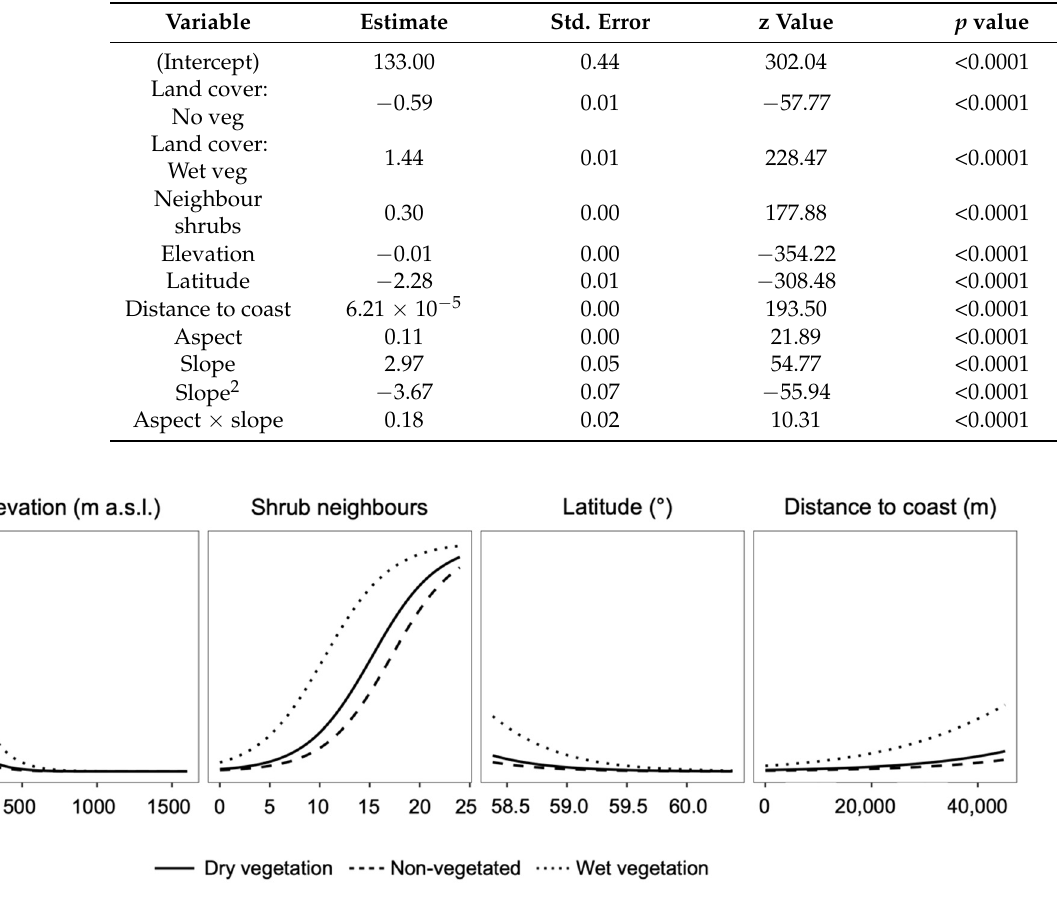
Figure 6. Modelled probabilities of dry vegetation, non-vegetated, and wet vegetation pixels undergoing a state transition to the shrub cover class based on changes in the four most influential variables in the binomial model. In each panel, the relationship between shrub probabilities and the predictor variable is shown with other model variables set to their average values. Model confidence intervals are not visible at this scale because they are very narrow, likely due to the large size of the dataset. Table 3. Model output of the selected binomial regression model in which the probability of a pixel being shrub dominant at time 2 (2014) was estimated from topographic and biotic variables at time 1 (1985/89).